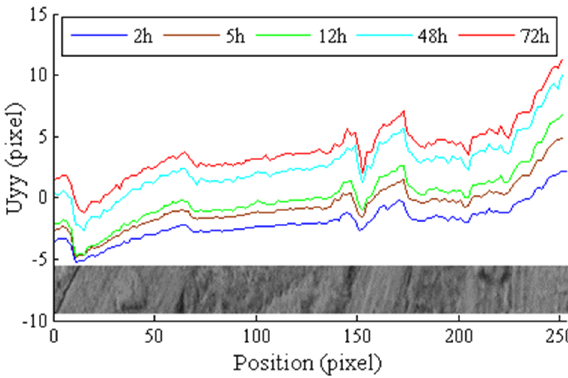
Figure 5. Displacements in the (cid:1877)(cid:1877) direction as a function of time in the middle of the sample (cut to 100